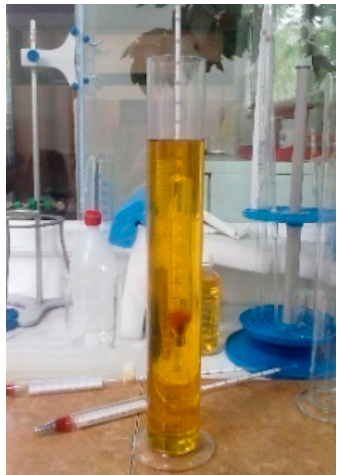
Figure 2. Fuels’ density measurement.